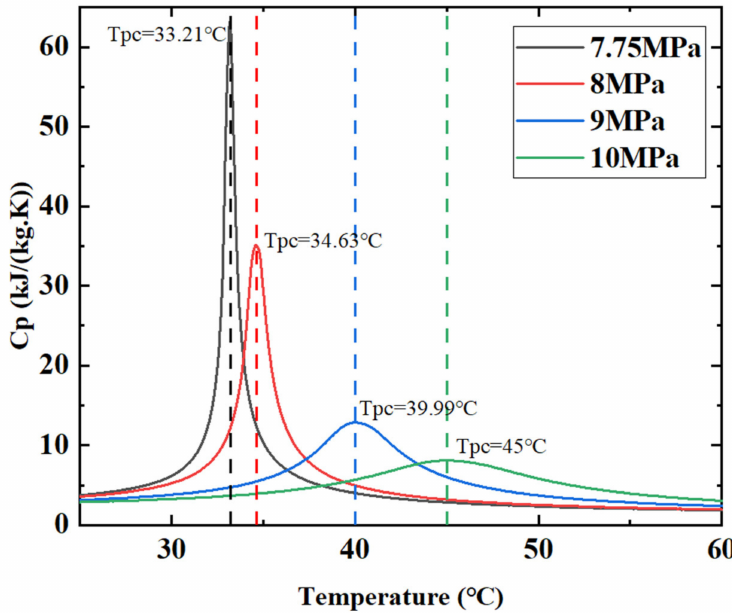
Figure 2. Variation in heat capacity for SCO 2 with pressure and temperature.